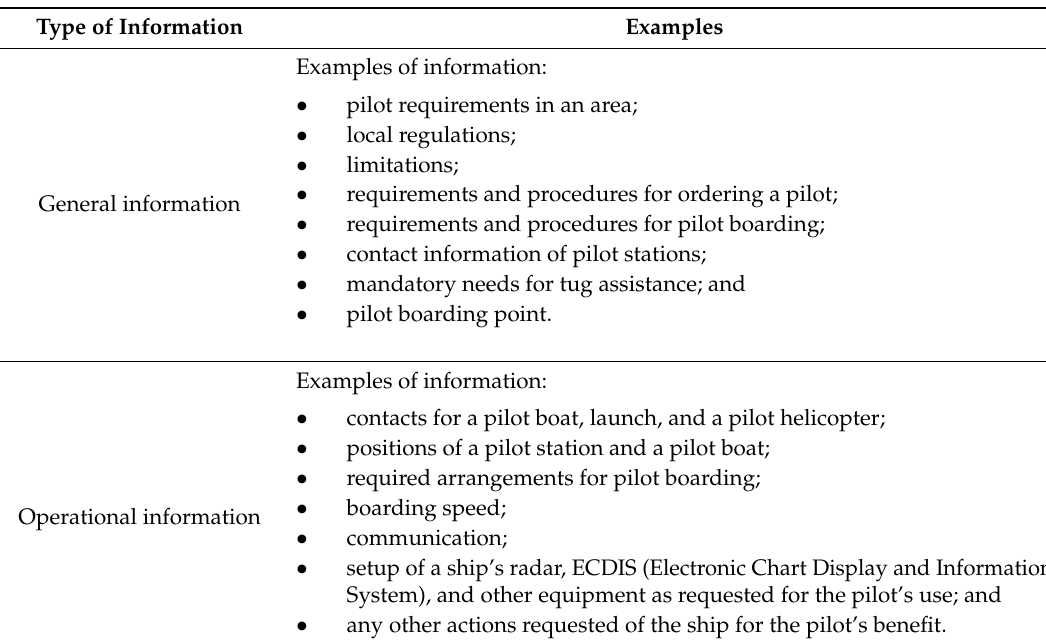
Table 4. Examples of information in MS 6